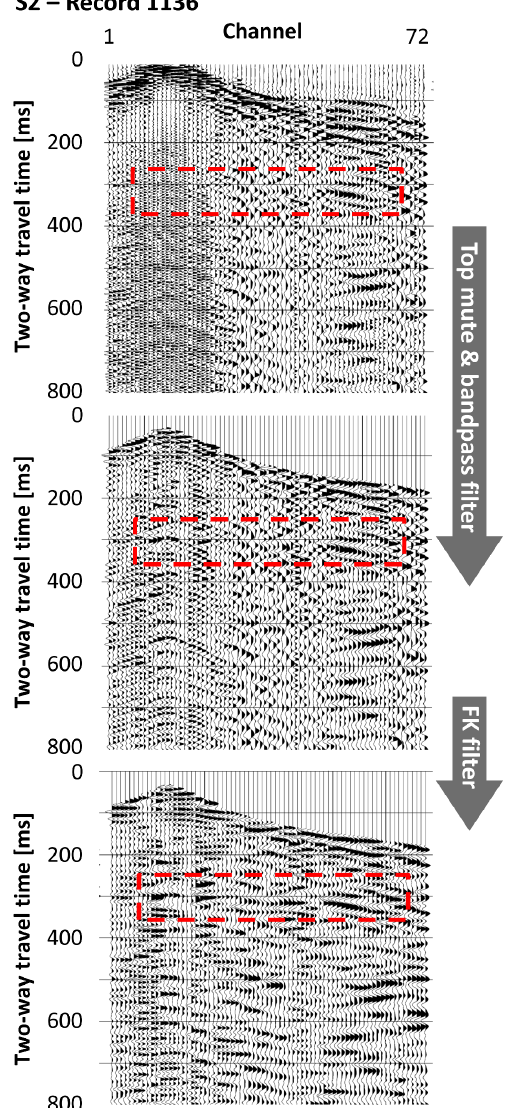
Figure 8. To eliminate noise and harmonic distortions, a bandpass filter and individual FK filters were applied to the records of each profile. The filtering in the frequency–wavenumber domain was one of the key processing steps to get interpretable seismic sections (note red box, showing the improved S/N ratio of near-surface re- flectors).